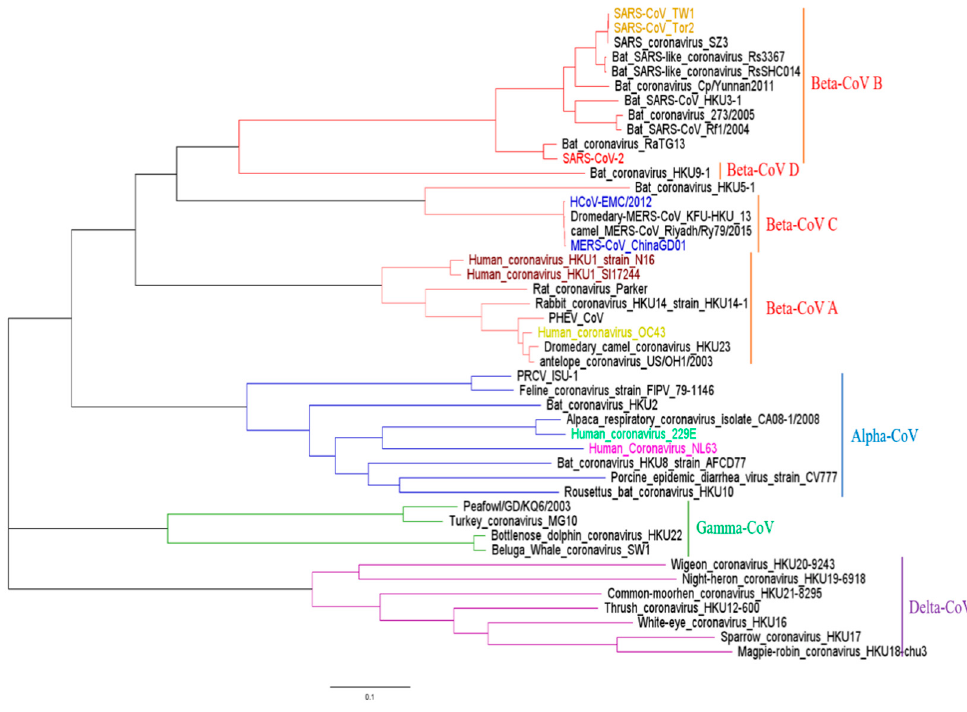
Figure 1. Phylogenetic analysis of full-length genomes of representative viruses of the existing coronavirus. Lines with different colors represent different coronavirus species, Alpha-coronaviruses (blue lines), Beta-coronaviruses (red lines), Gamma-coronaviruses (green lines), and Delta-coronaviruses (purple lines). Human isolates are highlighted with different colors, whereas strains from other hosts are shown in black. green: HCoV-229E; purple: HCoV-NL63; orange: SARS-CoV; red: SARS-CoV-2; blue: MERS-CoV; yellow: HCoV-OC43; brown: HCoV-HKU1. The scale bar is used to measure the branch length.